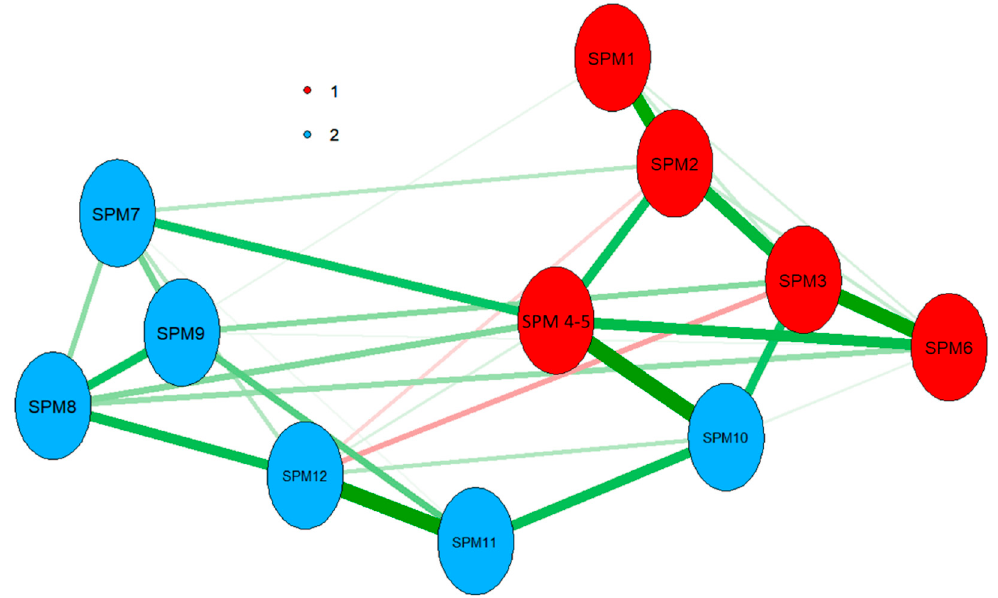
Figure A1. Principal component and parallel factor analysis with eigenvalue obtained from resampling from original data using a parcel for SPM4 and SPM5 items.